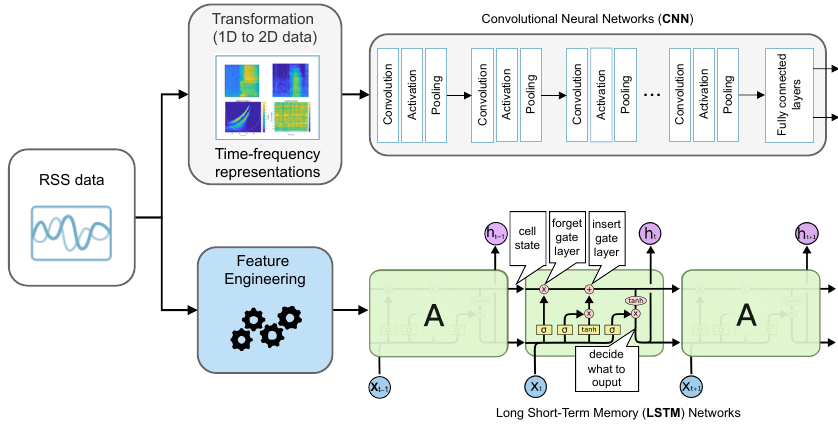
Figure 6. The proposed CNN and LSTM deep networks for RSS-based WLAN